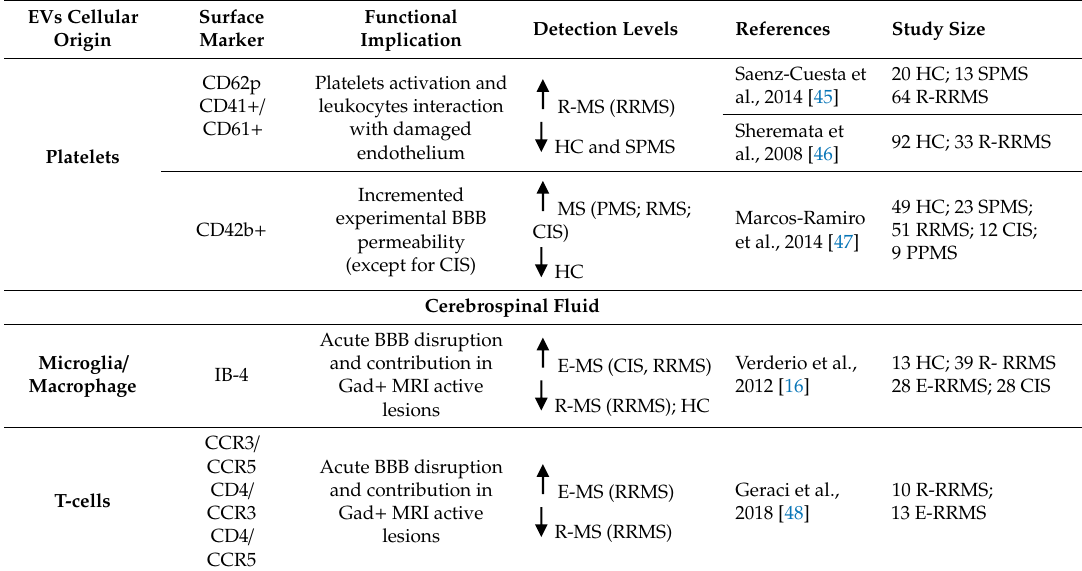
Table 1. Extracellular vesicle (EV) classification and their potential role in multiple sclerosis (MS).